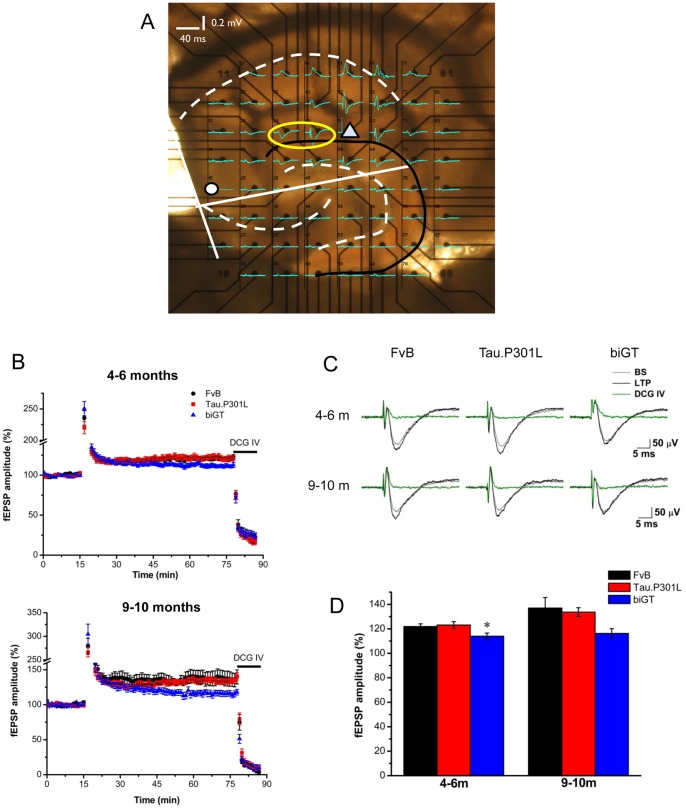
Electrophysiological analysis of LTP in SLM synapses in Tau.P301L and biGT mice.A. Image of hippocampal section on the MEA chip, with superimposed fEPSPs recorded in the SLM (yellow oval) in response to stimulation of the TA pathway (white triangle). White solid lines indicate where the section was cut to obtain pure TA responses. White dashed lines indicate granule and pyramidal cell body layers; black solid line indicates the hippocampal fissure. Electrode 15 (white circle) was used as internal ground electrode. B. fEPSPs tracings (mean±SEM) recorded in SLM in horizontal brain sections from young and old Tau.P301L and biGT mice. LTP was induced by 4 trains of high frequency stimulation (HFS) after 15 min of baseline recording. At the end of all recordings, DCG IV (3 µm) was added for 10 min. C. Representative tracings of fEPSPs at baseline (grey), at 60 min after HFS (black) and 10 min after DCG IV (green). D. fEPSPs amplitudes recorded between 30 and 60 min after HFS in young and old Tau.P301L and biGT mice (mean±SEM). Number of sections and mice: 4–6 months: FvB, n = 12 sections/8 mice; Tau.P301L, 11sections/6 mice; biGT 12 sections/6 mice; 9–10 months: FvB, n = 9 sections/6 mice; Tau.P301L 11 sections/6 mice; biGT, 8 sections/6 mice.